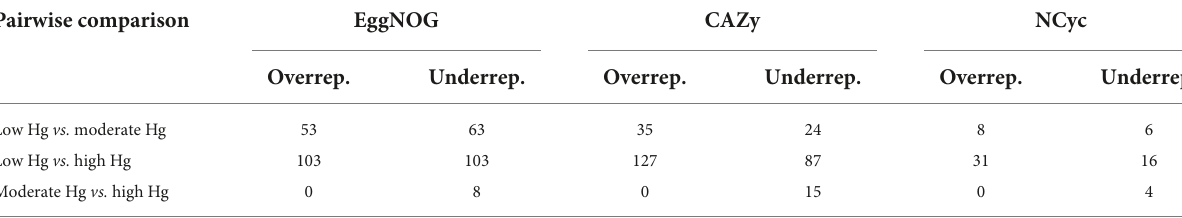
TABLE 4 Pairwise comparison and number of significantly ( P < 0.01) over- and underrepresented differentially abundant genes annotated with the EggNOG, CAZy, and NCyc databases of soils with different Hg contamination levels (low, moderate, high). Total counts: EggNOG 61,591, CAZy 39,632, and NCyc